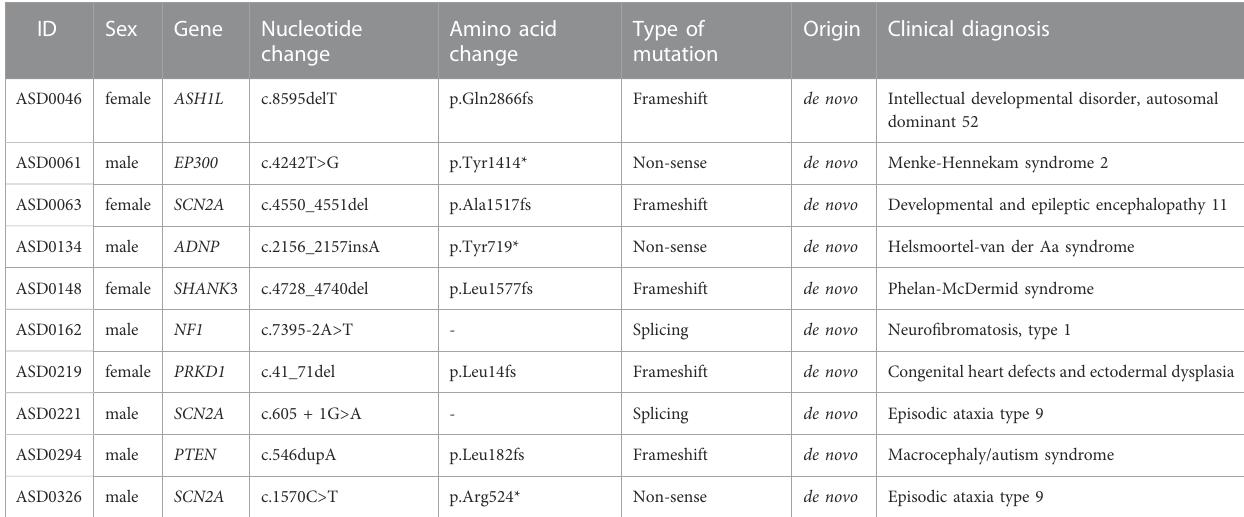
TABLE 3 SNV changes of 10 ASD